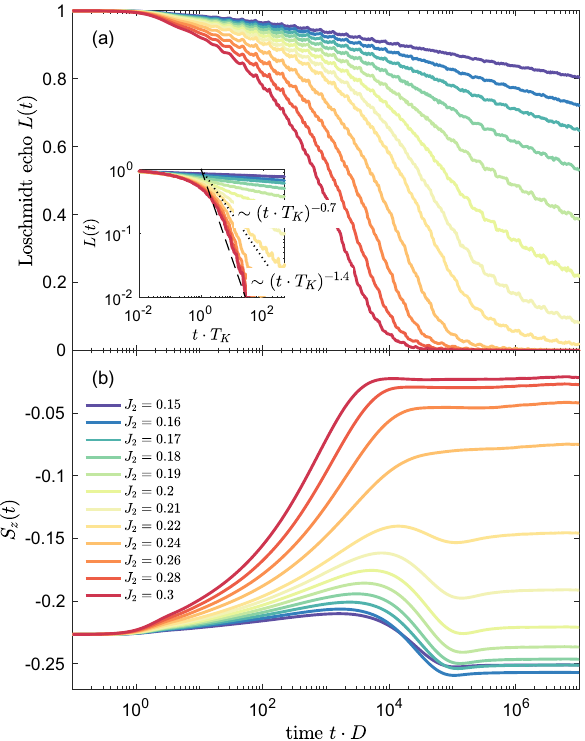
Figure 11. ( a ) The Loschmidt echo L ( t ) and ( b ) S z ( t ) for quantum quench in the coupling strength J 2 from J 2 = 0 to the value shown in the legend, with fixed J 1 = 0.2 and in the presence of magnetic field B z = 4 · 10 − 5 . The inset presents L ( t ) plotted vs time rescaled with the Kondo temperature T K . The other parameters are the same as in Fig.